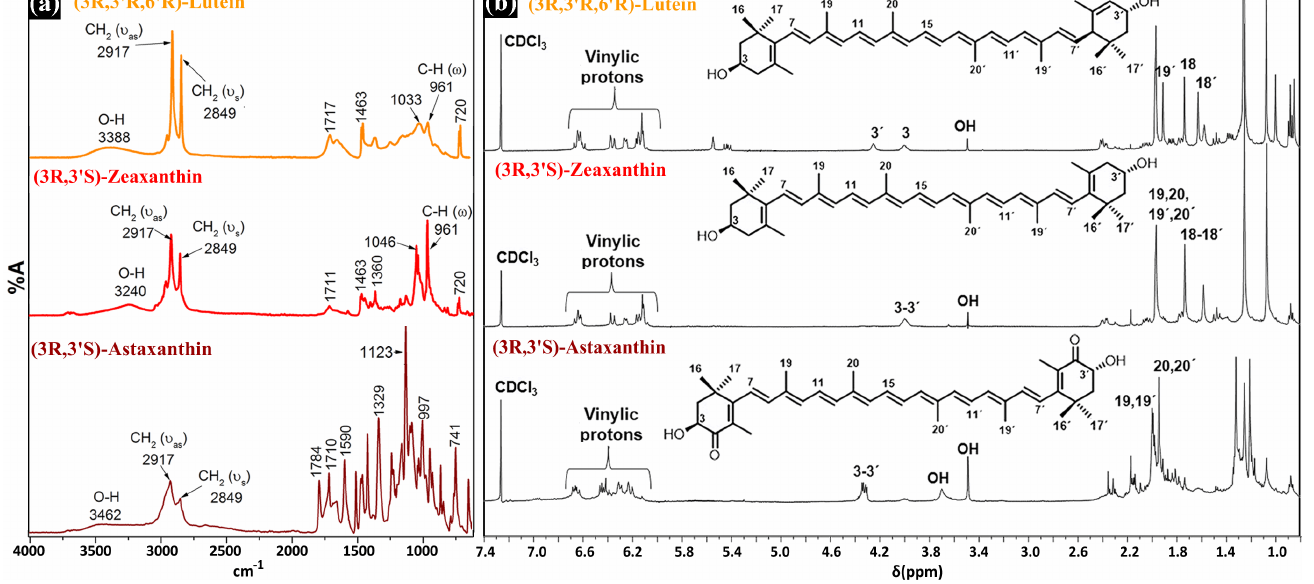
Figure 3. ATR − FTIR ( a ) and 1 H − RMN ( b ) spectra of xanthophylls.